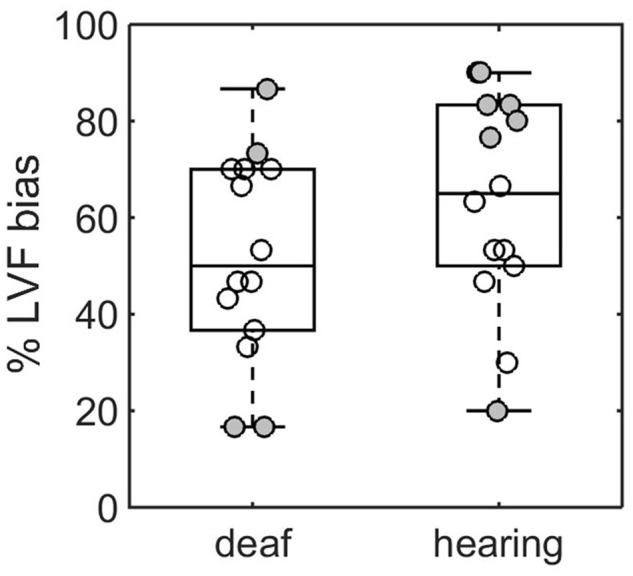
Visual field bias for deaf and hearing participants in Experiment 2. Box center and limit give the median, 1st and 3rd quartile. Each data point represents a participant. Filled data point indicates significant bias according to a χ2 statistics. Three participants showed a RVF bias (filled dots < 50%).